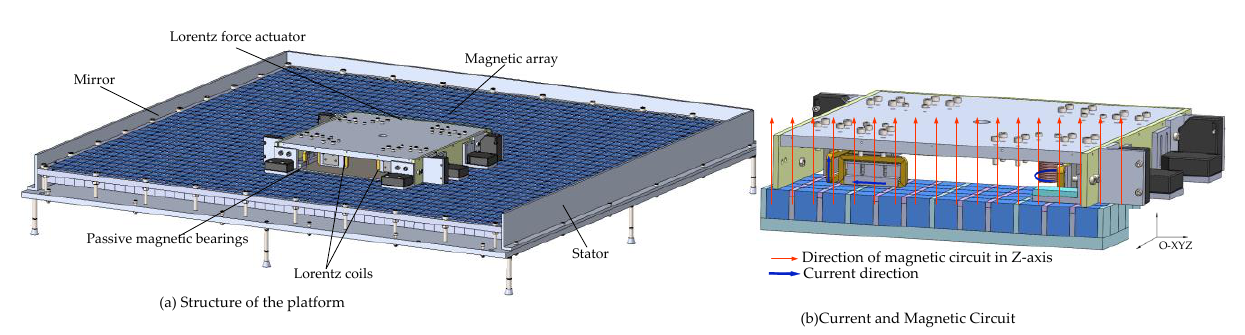
Figure 1. The structure of the 6-DOF magnetic suspension platform.